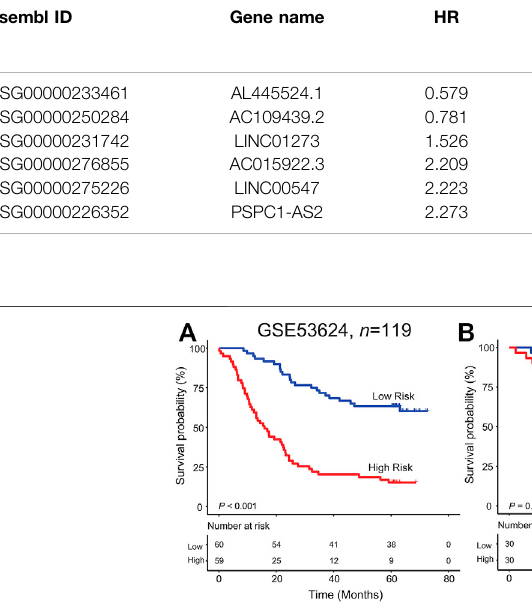
Frontiers in Genetics |